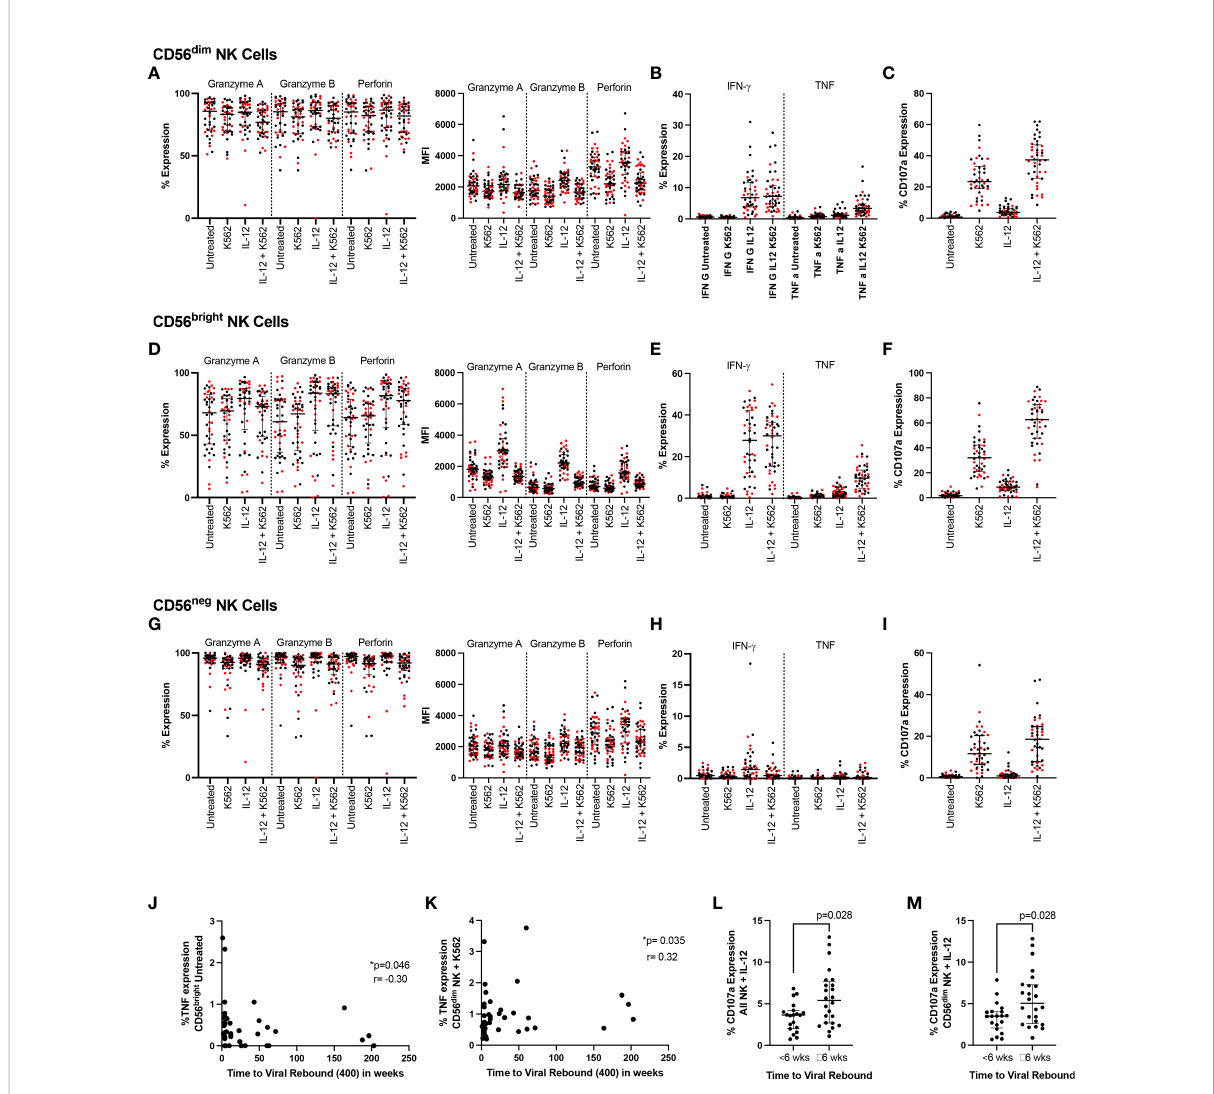
FIGURE 3 NK cell function and time to viral rebound. PBMC from SPARTAC participants (n = 44) were either cultured overnight in media or stimulated with 10ng/mL IL-12 and 100ng/mL IL-18. Cells were then cultured alone or with K562 cells at a 5:1 E:T ratio for 5 hours in the presence of CD107a. Cells were then stained intracellularly for granzyme (A) , granzyme (B) , perforin, IFN- g and TNF. Red circles indicate individuals with time to viral rebound < 6 weeks and black circles indicate individuals with time to viral rebound ≥ 6 weeks. Expression as a percent or median fl uorescent intensity is shown for CD56 dim NK (A – C) , CD56 bright NK (D – F) and CD56 neg NK cells (G – I) . In (J) and (K) , time to viral rebound was correlated with TNF expression in untreated CD56 bright NK cells and TNF expression in untreated CD56 dim NK cells co-cultured with K562 cells, respectively. A Spearman test was used and p and r values are shown. (L) and (M) show comparisons between individuals with time to viral rebound < 6 weeks compared to ≥ 6 weeks for CD107a expression in all NK cells (L) and CD56 dim NK cells (M) stimulated with IL-12 and IL-18. For all graphs, median values with interquartile range are